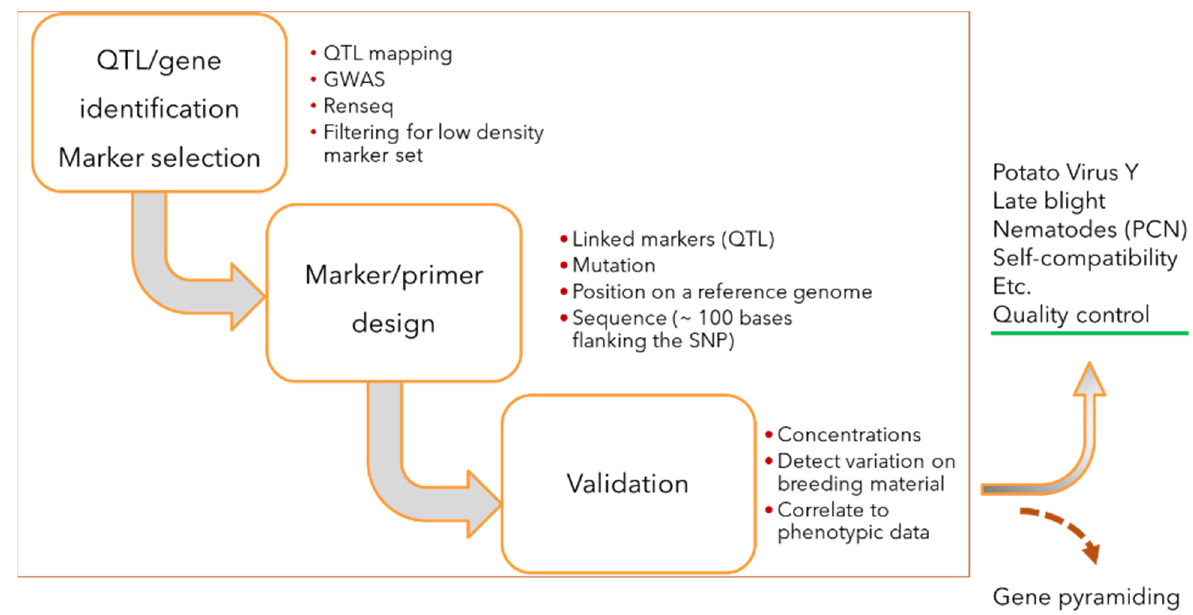
Figure 1. Workflow for KASP marker development and validation from association analysis or SNP marker selection. QTL, quantitative trait loci; GWAS, genome-wide association study; Concentrations, two different DNA concentrations (standard and diluted), whereby results from the two concentrations allow for the determination of the assay’s stability and, therefore, sensitivity to DNA concentration; SNP, single nucleotide polymorphism; PCN, potato cyst nematodes.